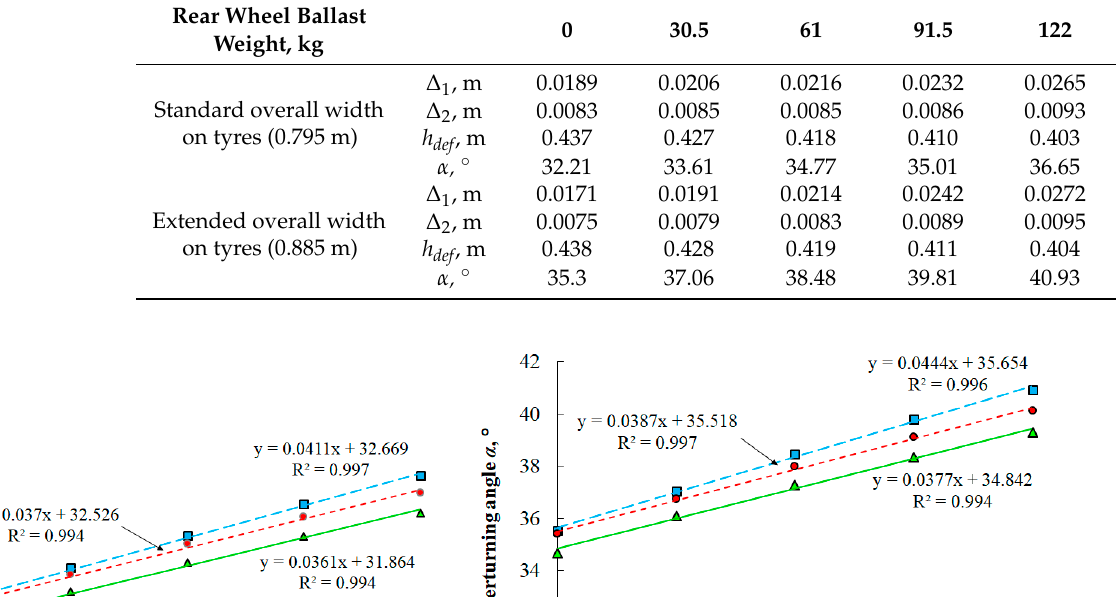
Table 4. Data calculated according to standard [12] considering the vertical tyre deformation.